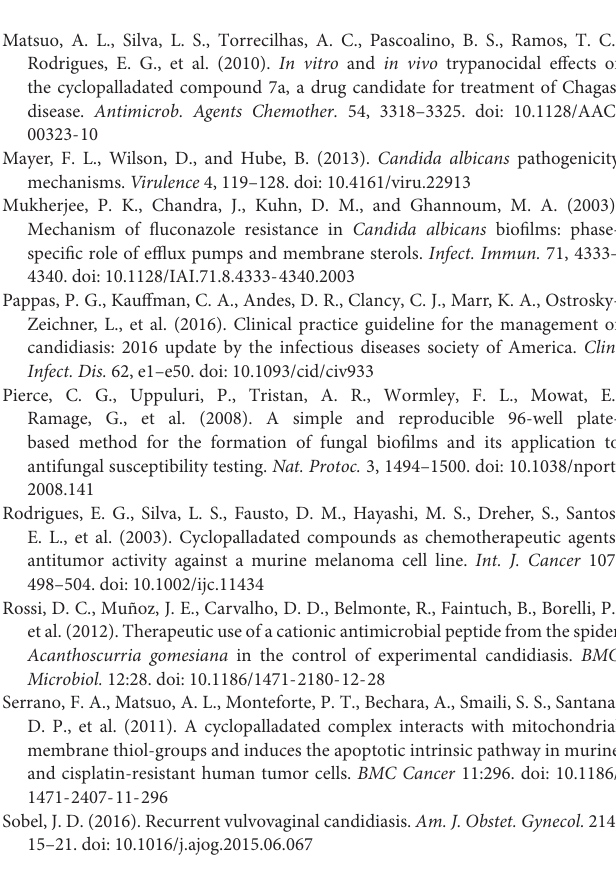
FIGURE S1 | Additional images showing morphological alterations in C7a-treated cells. Transmission electron microscopy of Candida albicans ATCC 10231 yeast cells untreated (A–C) and treated with 0.5 µ g/ml of C7a (D–F) for 24 h at 37 ◦ C in RPMI 1640 buffered with MOPS 0.16 M. n, nucleus; m, mitochondria; v, vacuole. Arrowheads, damage at cell wall. Bars = 1